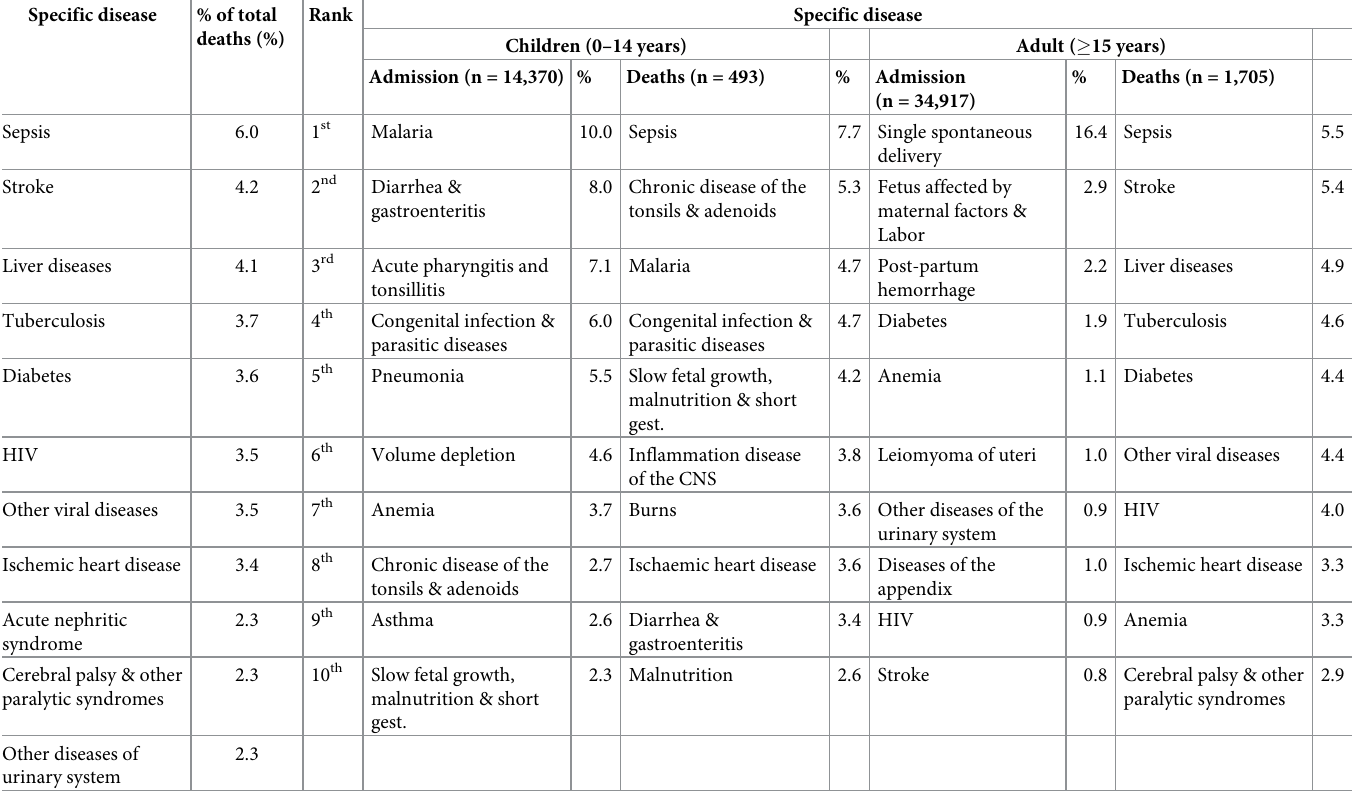
Table 5. Summary of the leading seven specific causes of mortality in the study. Specific disease % of total Rank deaths (%)